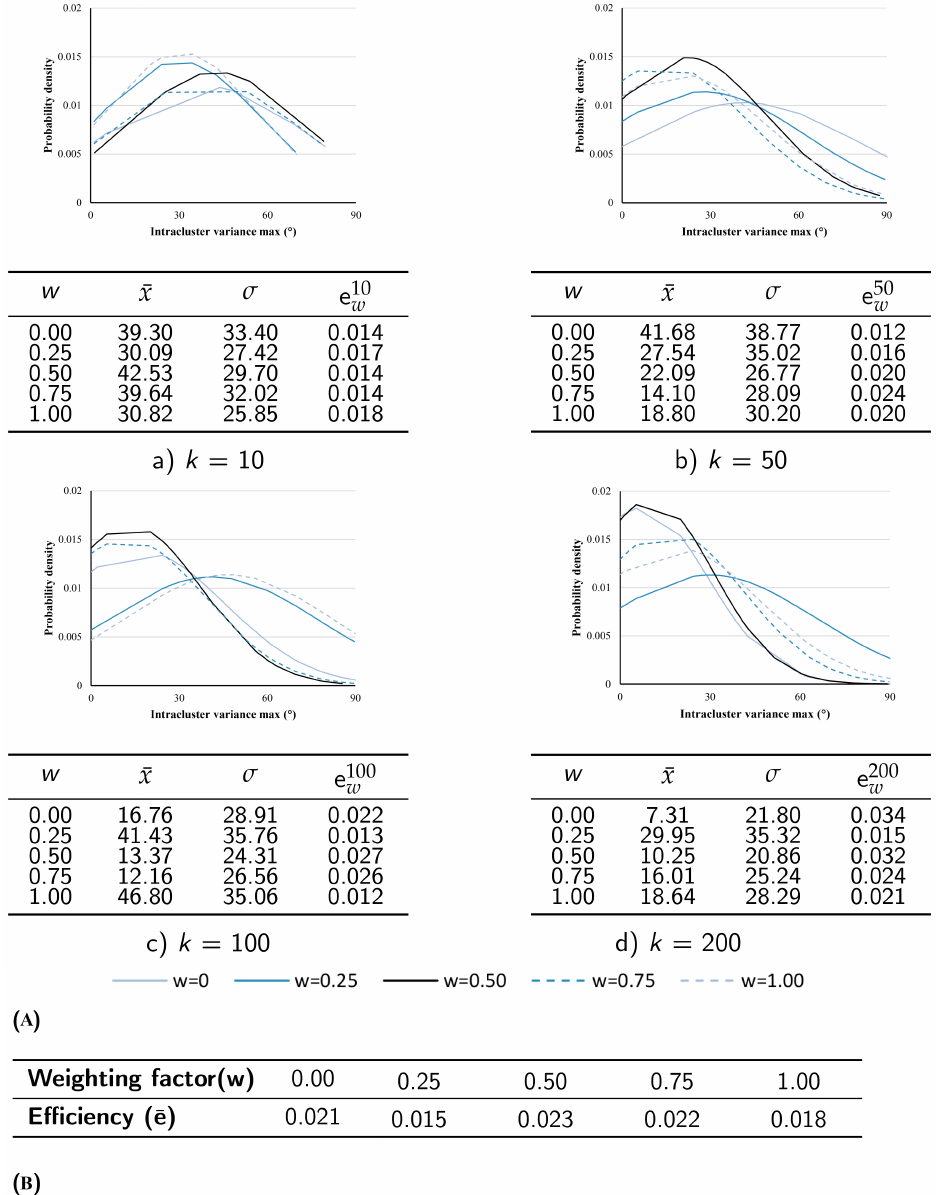
Figure 10. ( A ) Distribution of the intracluster variance of the k and w values studied. ( B ) The overall performance ranking of the different weighting